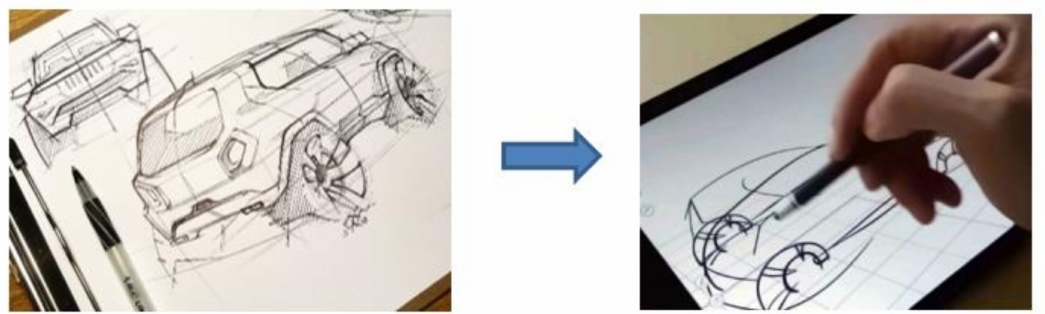
Figure 37. From sketch to sheet of paper with pencil to digital sketching.